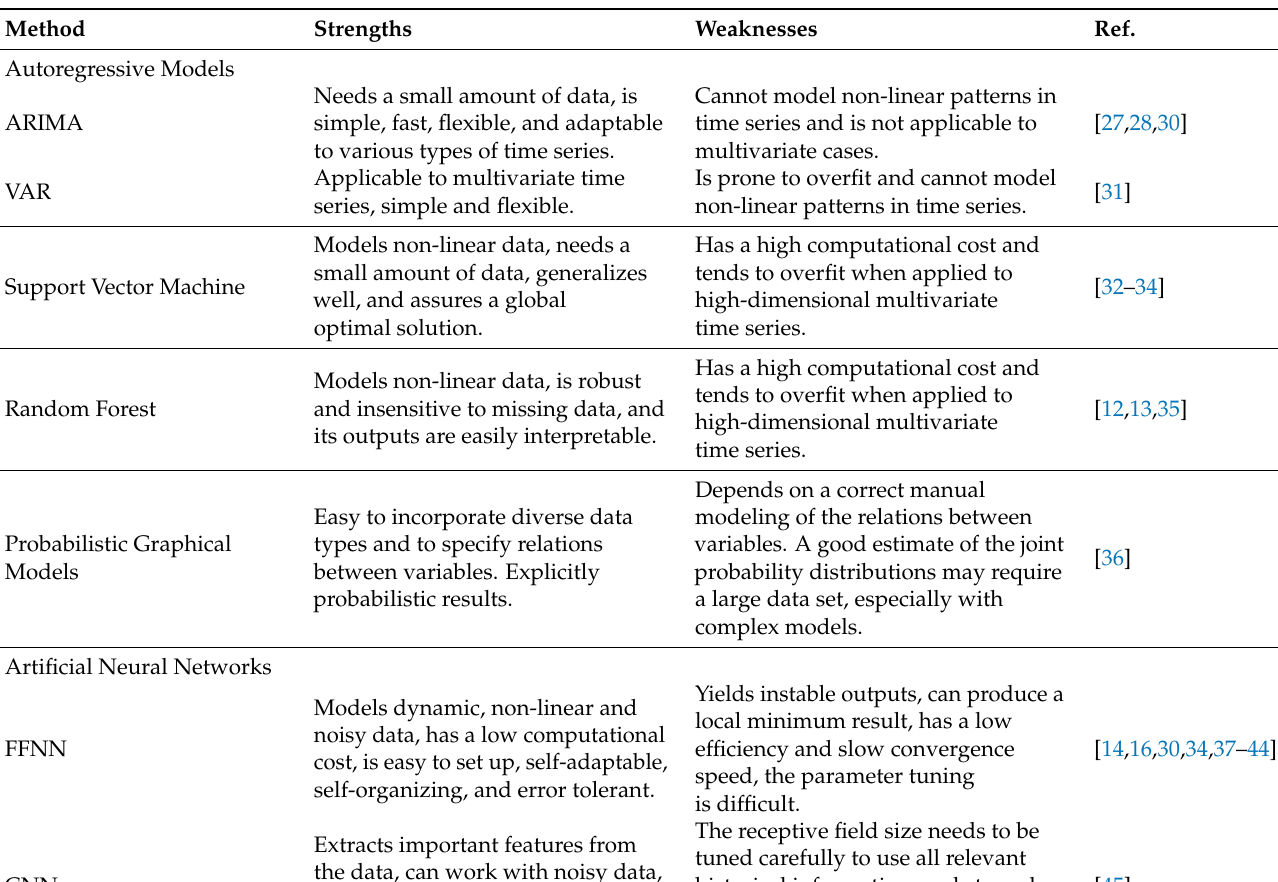
Table 1. Strengths and weaknesses of time-series methods applied in studies to forecast HABs and shellfish contamination (ARIMA, Autoregressive Integrated Moving Average; VAR, Vector Autoregression; FFNN, Feed-Forward Neural Network; CNN, Convolutional Neural Network; RNN, Recurrent Neural Network; LSTM, Long Short-Term Memory).